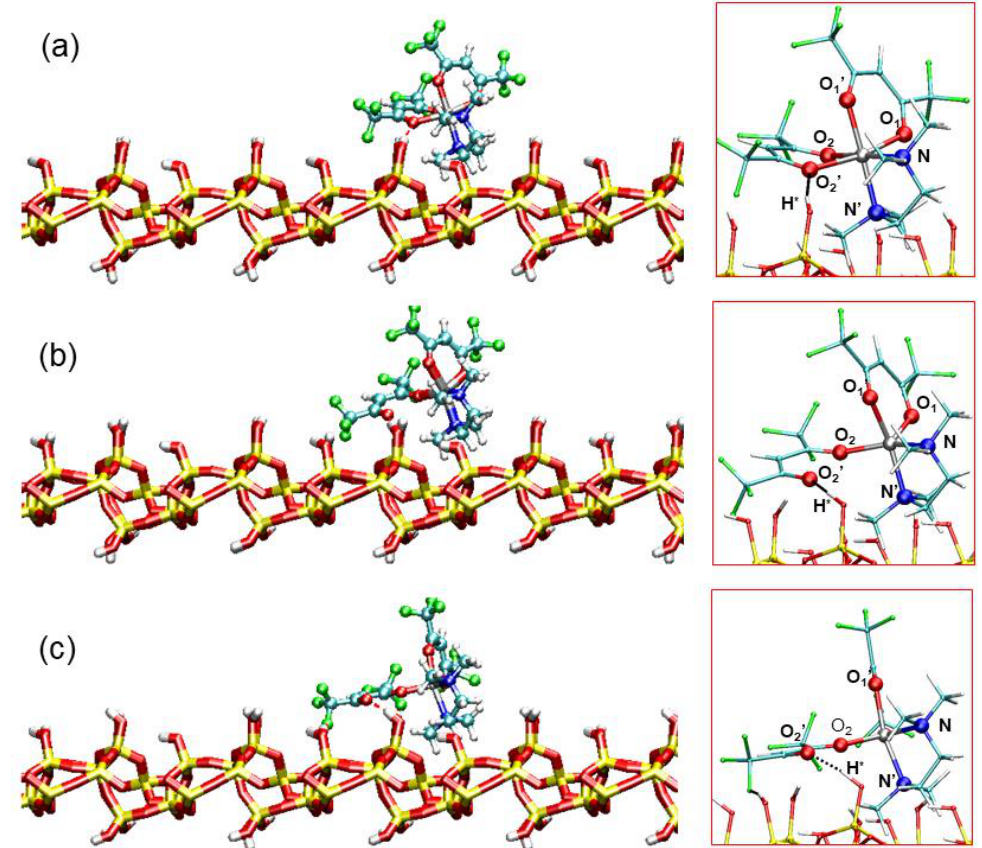
Figure 6. Optimized geometries of the ( a ) octahedral Zn(hfa) 2 TMEDA complex (initial state), ( b ) transition state, and ( c ) pyramidal Zn(hfa) 2 TMEDA (final state) on the hydroxylated silica slab (PBE-D2/PW level of theory). The insets on the right side of the ( a – c ) panels highlight the coordi- nation environment of Zn and the O 2′ -H* hydrogen bond. Color codes: Zn, gray; F, green; O, red; N, blue; C, cyan; H, white; Si: yellow. Labels as in Figure 1 and Tables 1 and 3. The hydrogen bond of the detached hfa oxygen O 2′ with the surface proton H* is indicated as a dotted line.